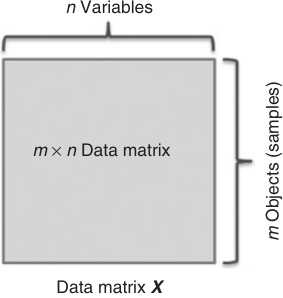
Figure 1: Schematic representation of how fingerprints are organ- ized in a data matrix suitable for multivariate data analysis.